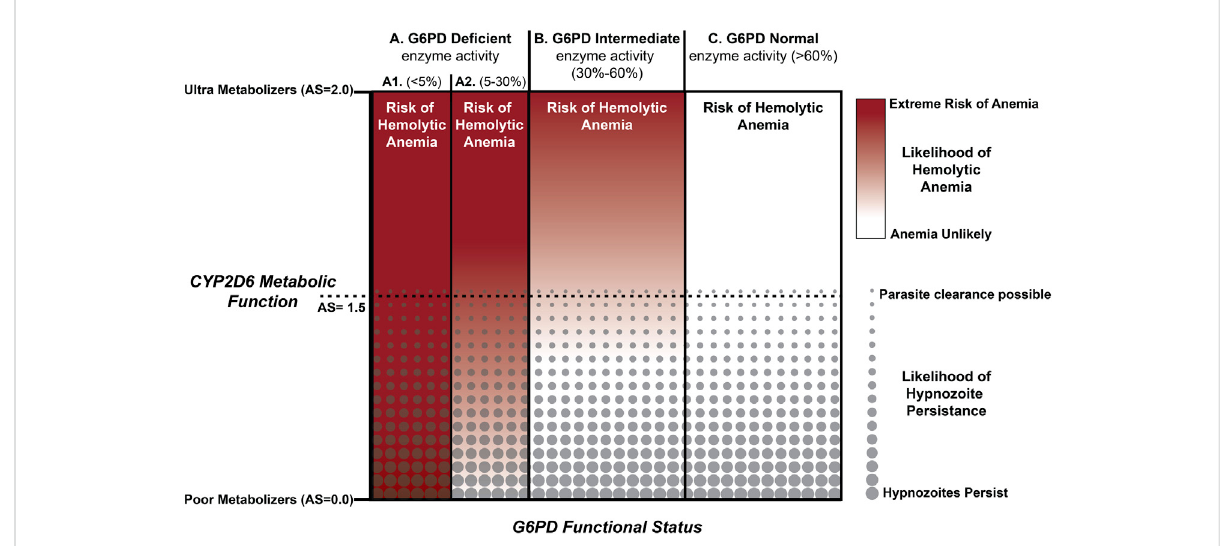
Integration of CPY2D6 Metabolic Function and G6PD Enzyme Activity. Those with a CYP2D6 AS < 1.5 are predicted to have an elevated risk of relapse. PQ failure with AS > 1.5 appears to be less common and for those with AS > 2.0 radical cure success improves substantially following current standard of care. Integrated across the familiar G6PD enzyme activity benchmarks, potential exists for optimizing treatment strategies for all but those individuals with < 5% G6PD enzyme